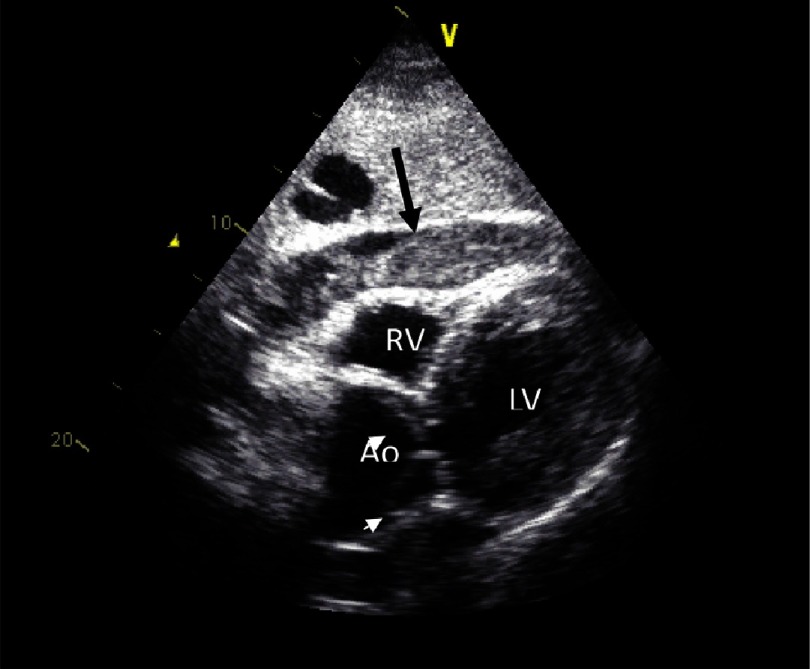
TTE shows pericardial effusion Black arrow) with compression of the right ventricle and collapse of the right atrium secondary to pericaldial tamponade.Note aortic root enlargement with an intimal flap (white small arrows).